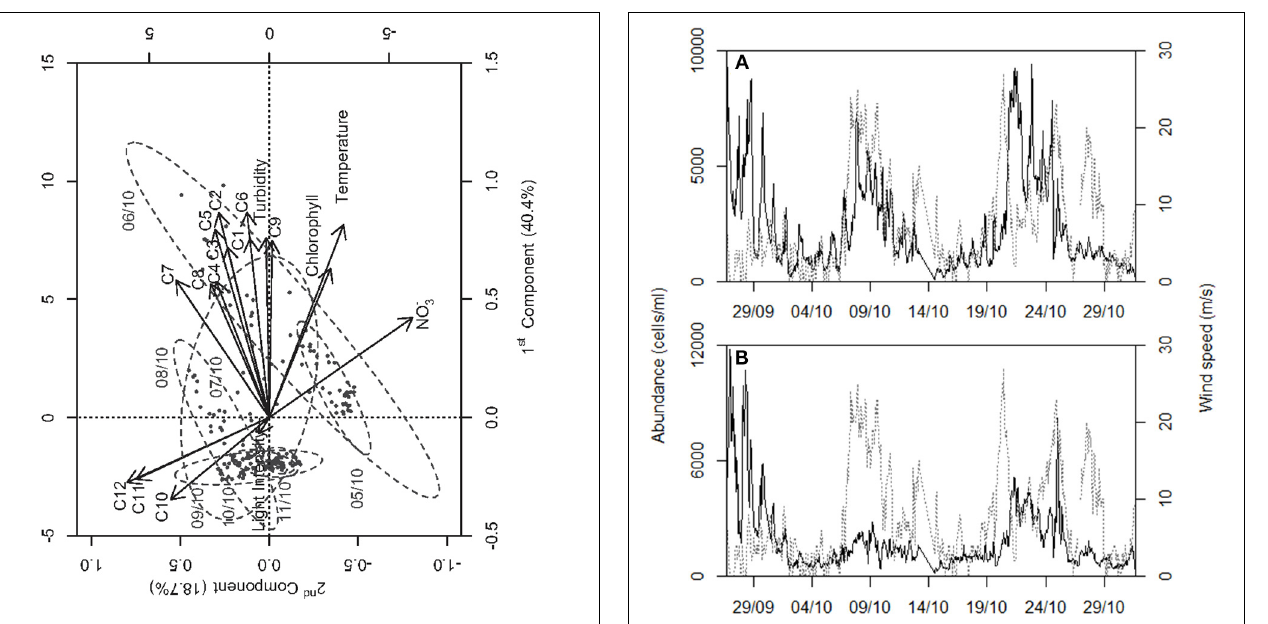
FIGURE 9 | Time series of the (A) C11 cluster and (B) C12 cluster abundances (black line) during the sampling period, characterized by two strong Mistral event (gray dotted